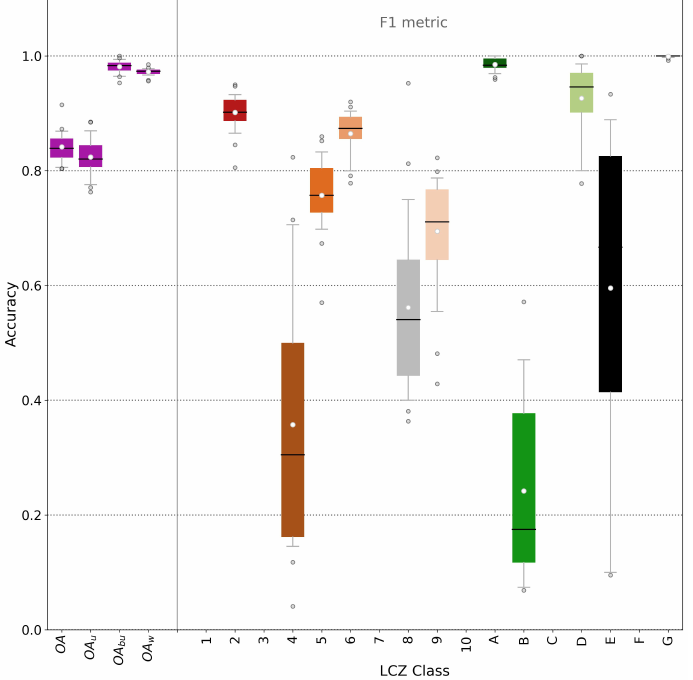
Figure 8. Boxplot accuracy of the LCZ generator map for the new training areas of Berlin; data from [39] (see also [15]).